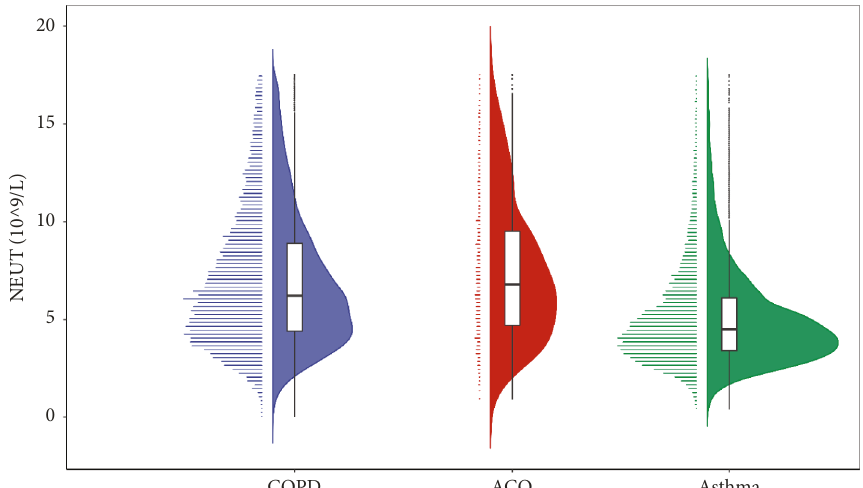
Figure 5: The neutrophil counts in the three study populations. (COPD, chronic obstructive pulmonary disease; ACO, asthma-COPD overlap; NEUT,